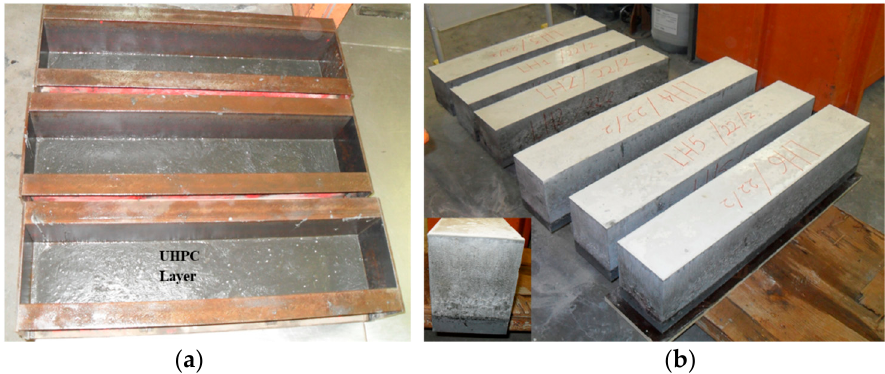
Figure 2. ( a ) UHPC layers prior casting the NC, ( b ) Hybrid NC-UHPC beams before